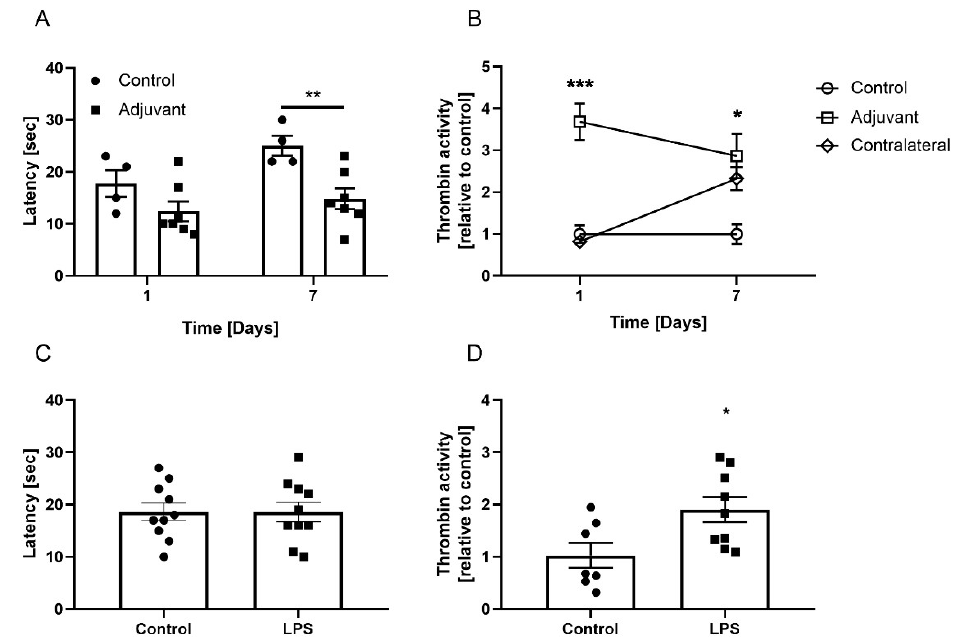
Figure 4. Heat sensitivity and thrombin activity in the skin of focal and systemic inflammation- induced mice. Adjuvant-induced focal inflammation in ICR mice: ( A ) Significantly higher heat sensitivity was found one week following adjuvant injection compared with the controls. n = 10 and 4, respectively. ( B ) Thrombin activity in the injected paw was significantly higher compared with the contralateral paw and the control group 24 h following adjuvant injection. Thrombin activity in the skin of the injected and the contralateral paws was significantly higher compared with the control group one week following adjuvant injection. n = 7 and 8. LPS-induced inflammation in C57BL/6J mice: ( C ) No difference in heat sensitivity between the groups was found one week following LPS injection. n = 10. ( D ) Significantly higher thrombin activity was found in the skin of LPS mice compared with that of the controls. n = 9 and 7, respectively. Thrombin activity results are presented relative to the controls. Results are presented as mean ± SEM, * p < 0.026, ** p < 0.009, *** p < 0.0009.